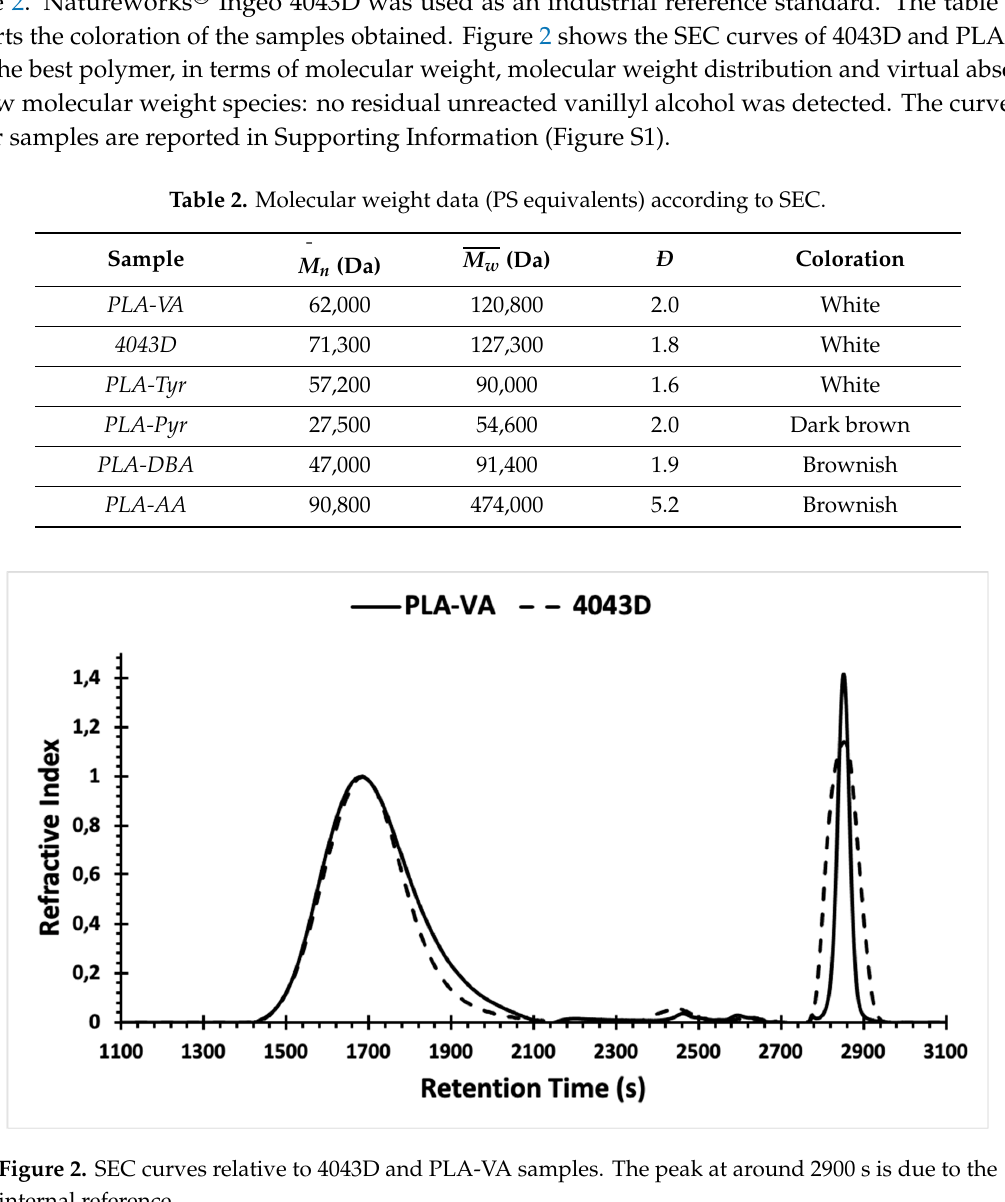
Figure 2. SEC curves relative to 4043D and PLA-VA samples. The peak at around 2900 s is due to the internal reference. internal